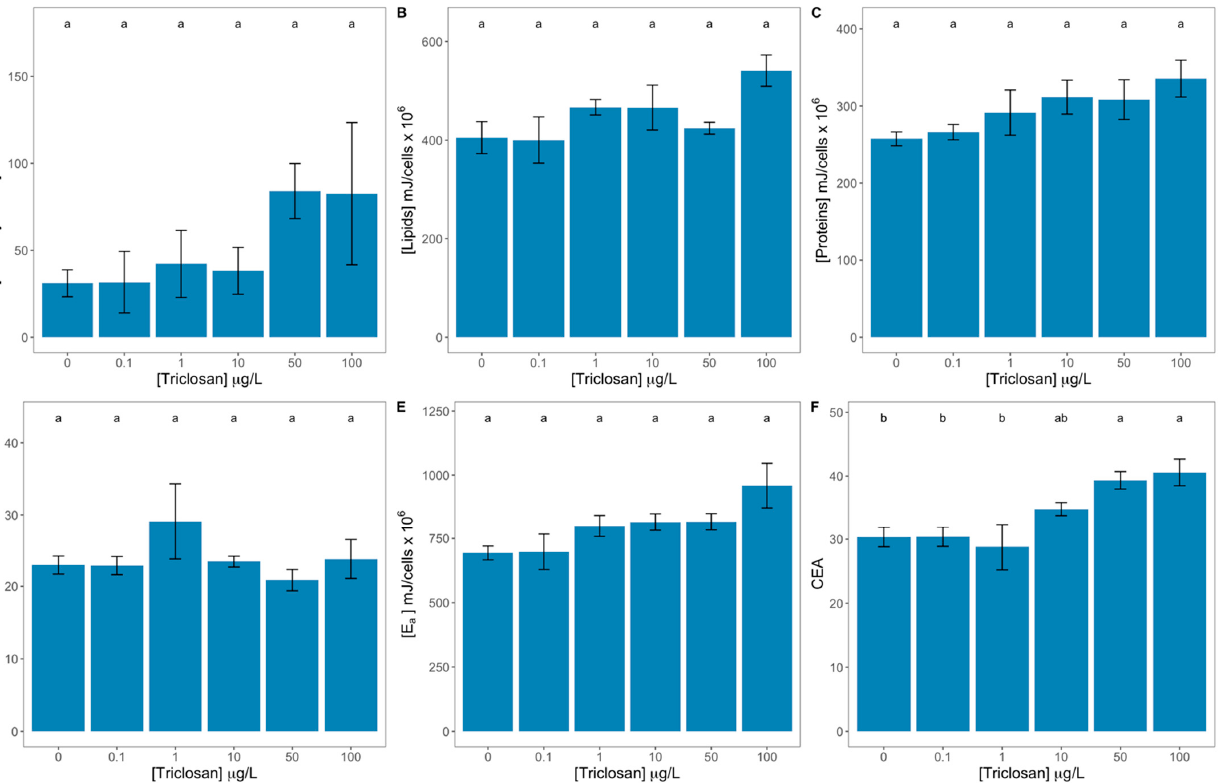
Figure 7. Triclosan-exposed Phaeodactylum tricornutum cultures energetic traits [carbohydrates ( A ), lipids ( B ), proteins ( C ), electron transport system (ETS, D ), available energy (E a , E ), and cellular energy allocation (CEA, F )] (average ± standard error, n = 3; different letters denote significant differences between triclosan treatments at p < 0.05).